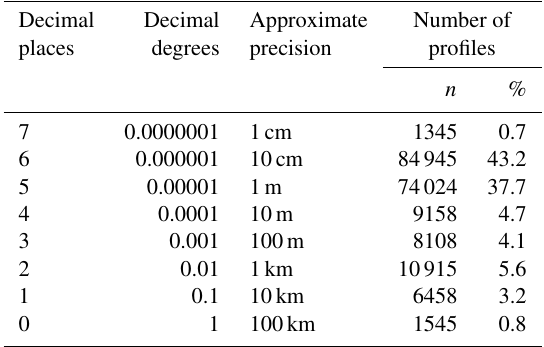
Table 2. Approximate accuracy of the profile